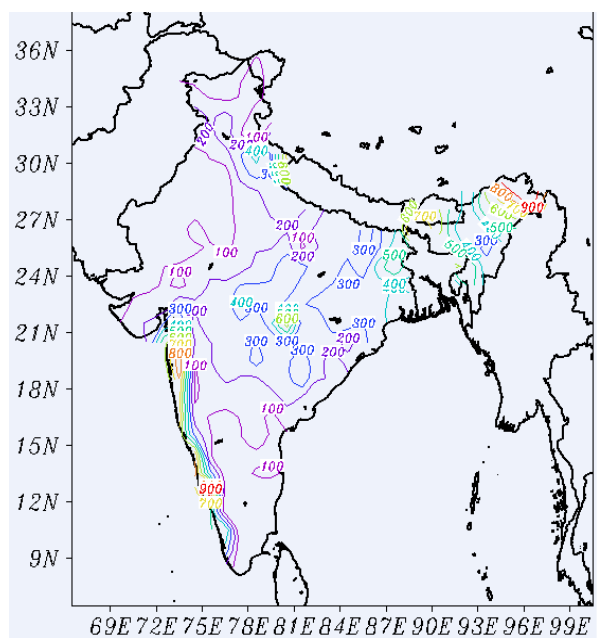
Fig. 14. IMD rainfall (mm) 2003